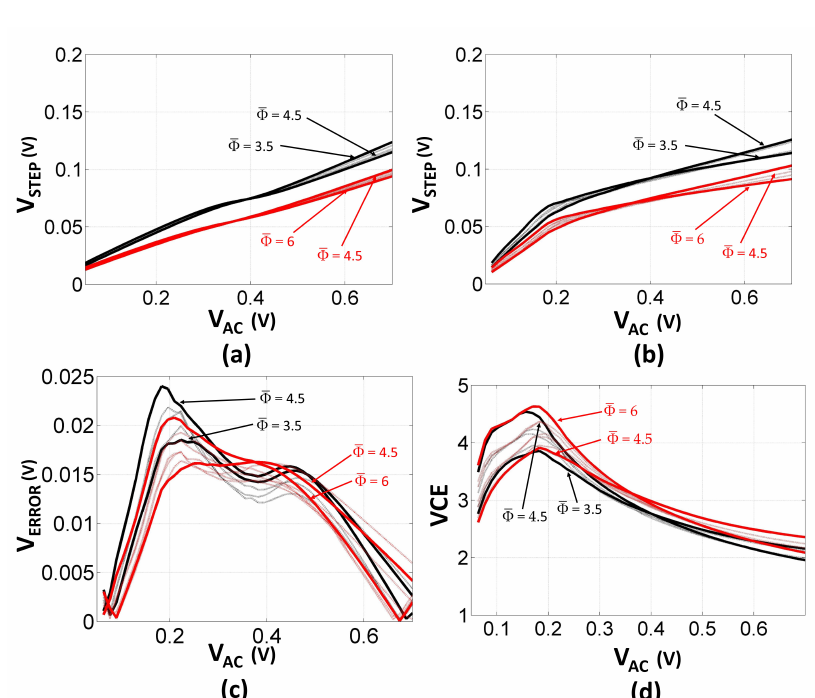
Figure 12. Voltage waveforms for ( a ) the modeled and ( b ) the simulated step voltage versus V AC , with ( c ) error characterization for the proposed model, and ( d ) simulated voltage conversion efficiency (VCE) for the different compensation techniques. ( N = 16 with | Φ | = 6, 5.875, 5.75, 5.5, 5.25, 4.875, 4.5; N = 12 with | Φ | = 4.5, 4.333, 4.166, 3.833, 3.5; C = 3 pF; L = 95 nm; W = 12 µm; f = 1